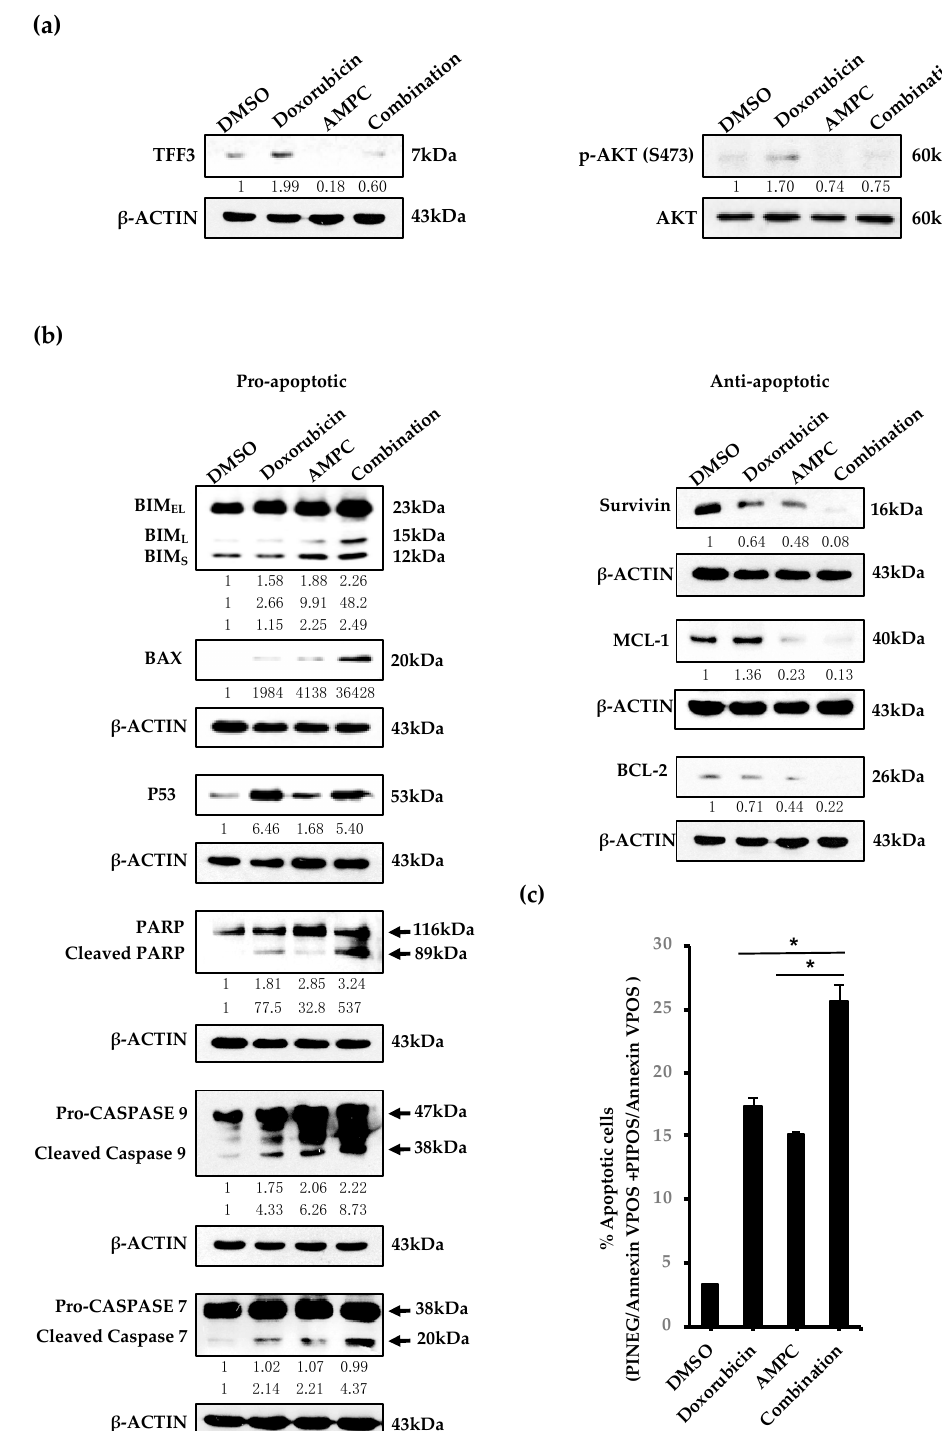
TFF3 induced by doxorubicin, with consequent inhibition of the downstream doxorubicin-induced AKT activation.